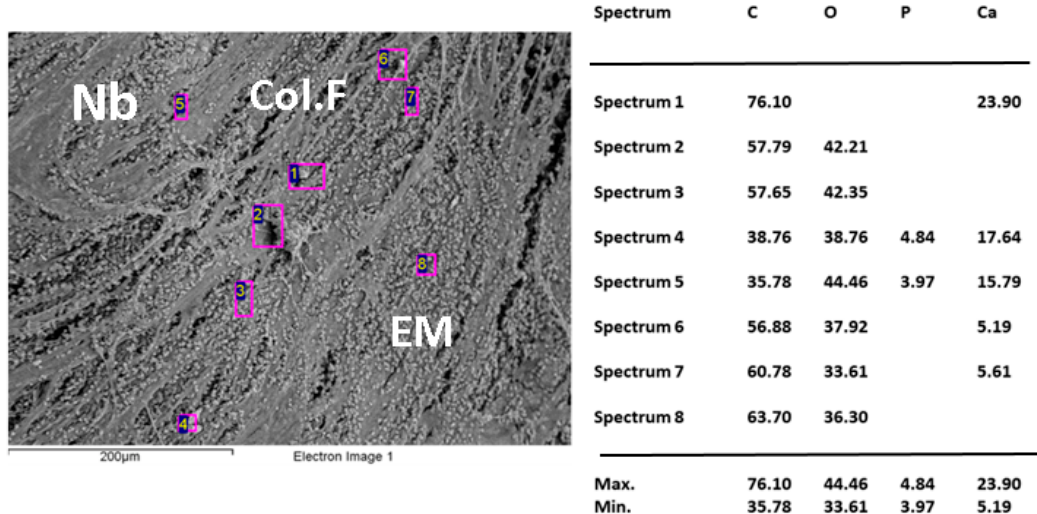
Figure 7. Scanning electron microscopy (SEM)/dispersive energy spectroscopy (EDS) analysis of CS-GO 1% sample implanted in critical size defects in rat parietal bone Wistar . Nb: Newly born bone. EM: Extracellular matrix. Col-F: collagen fiber.